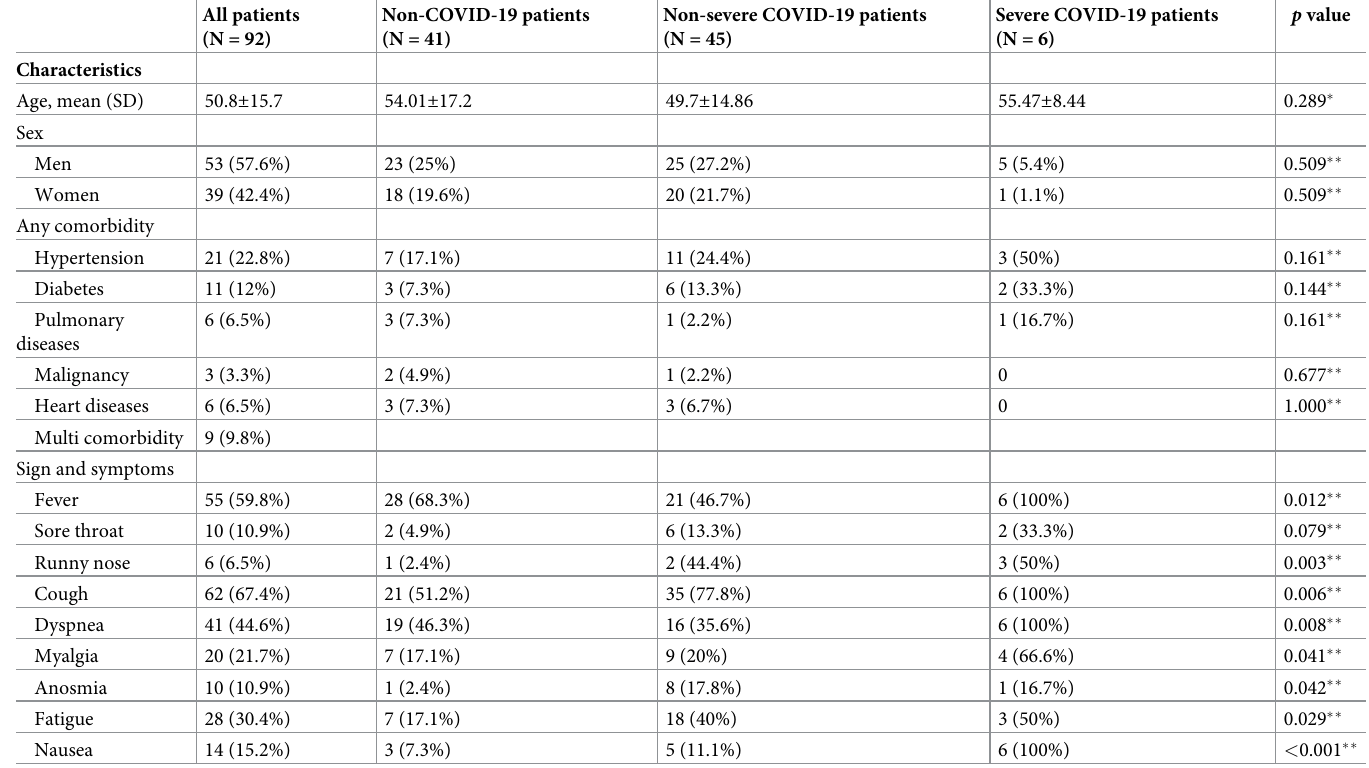
Table 1. Demographics and baseline characteristics of patients infected with COVID-19 and non-COVID-19 patients. All patients (N =